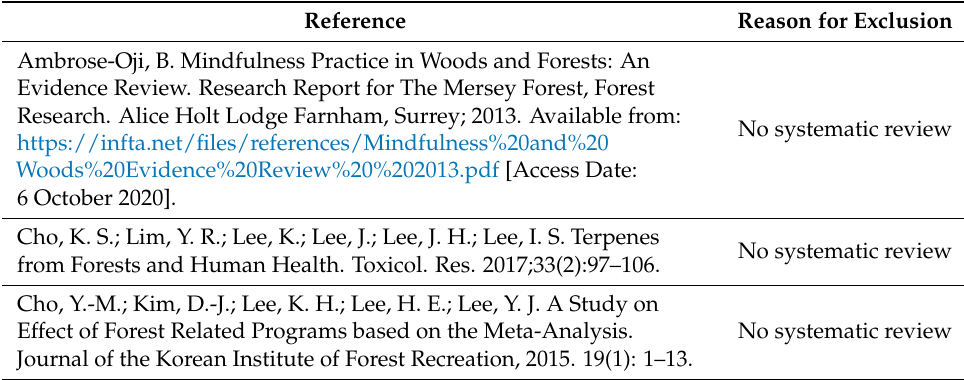
Table A11. Excluded references after full text